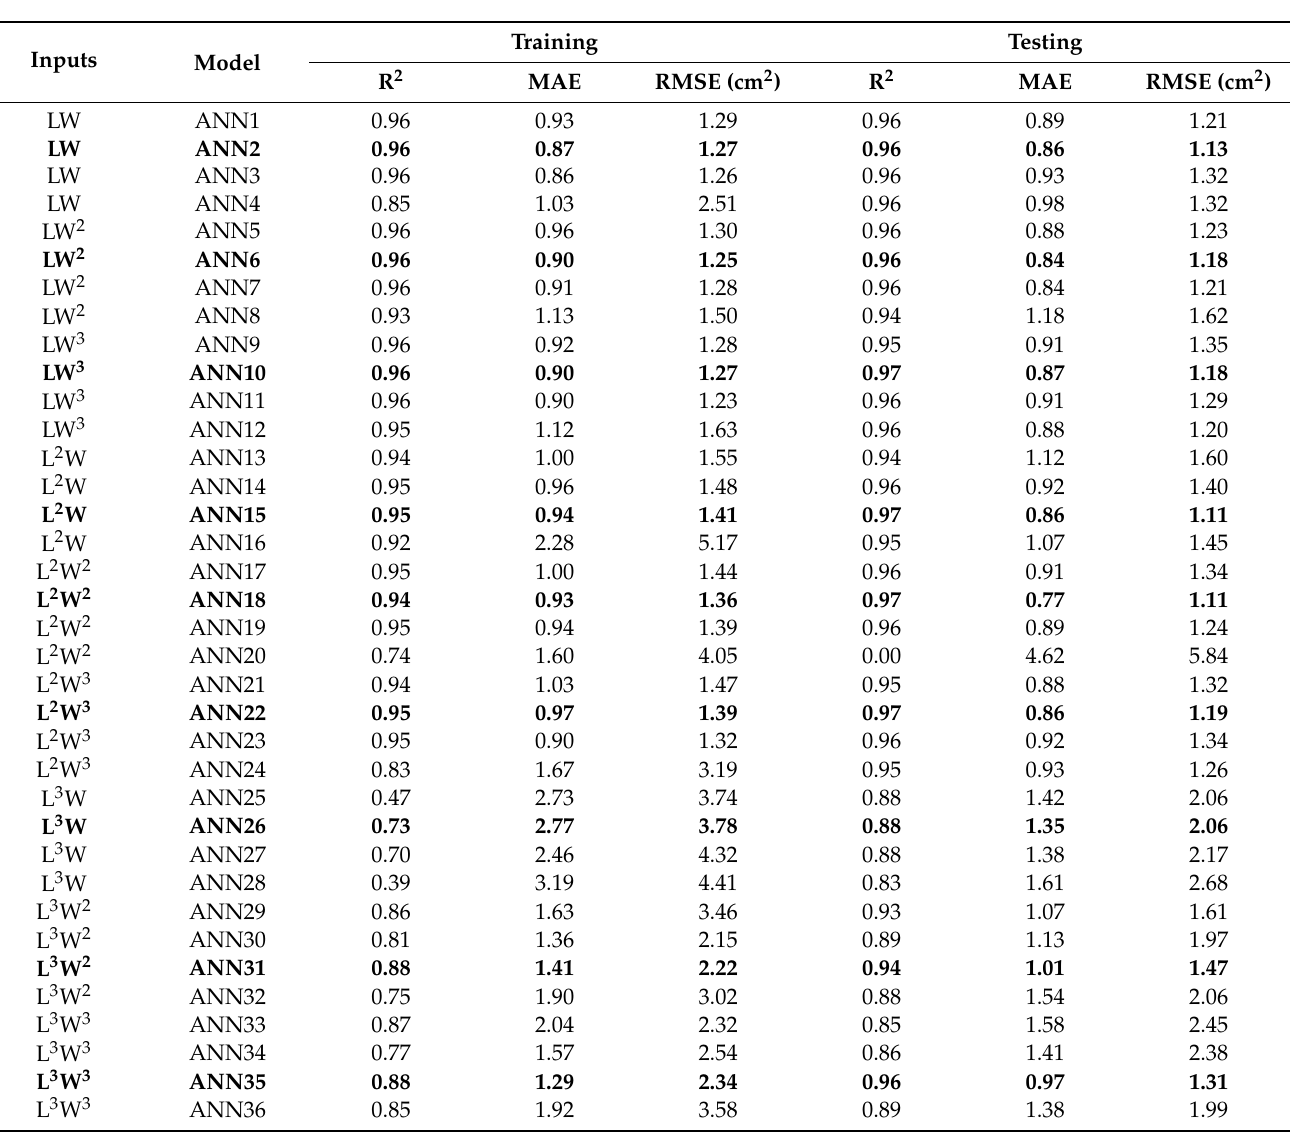
Table 6. Comparative analysis of 36 ANN models with different inputs, i.e., LW, LW 2 , LW 3 , L 2